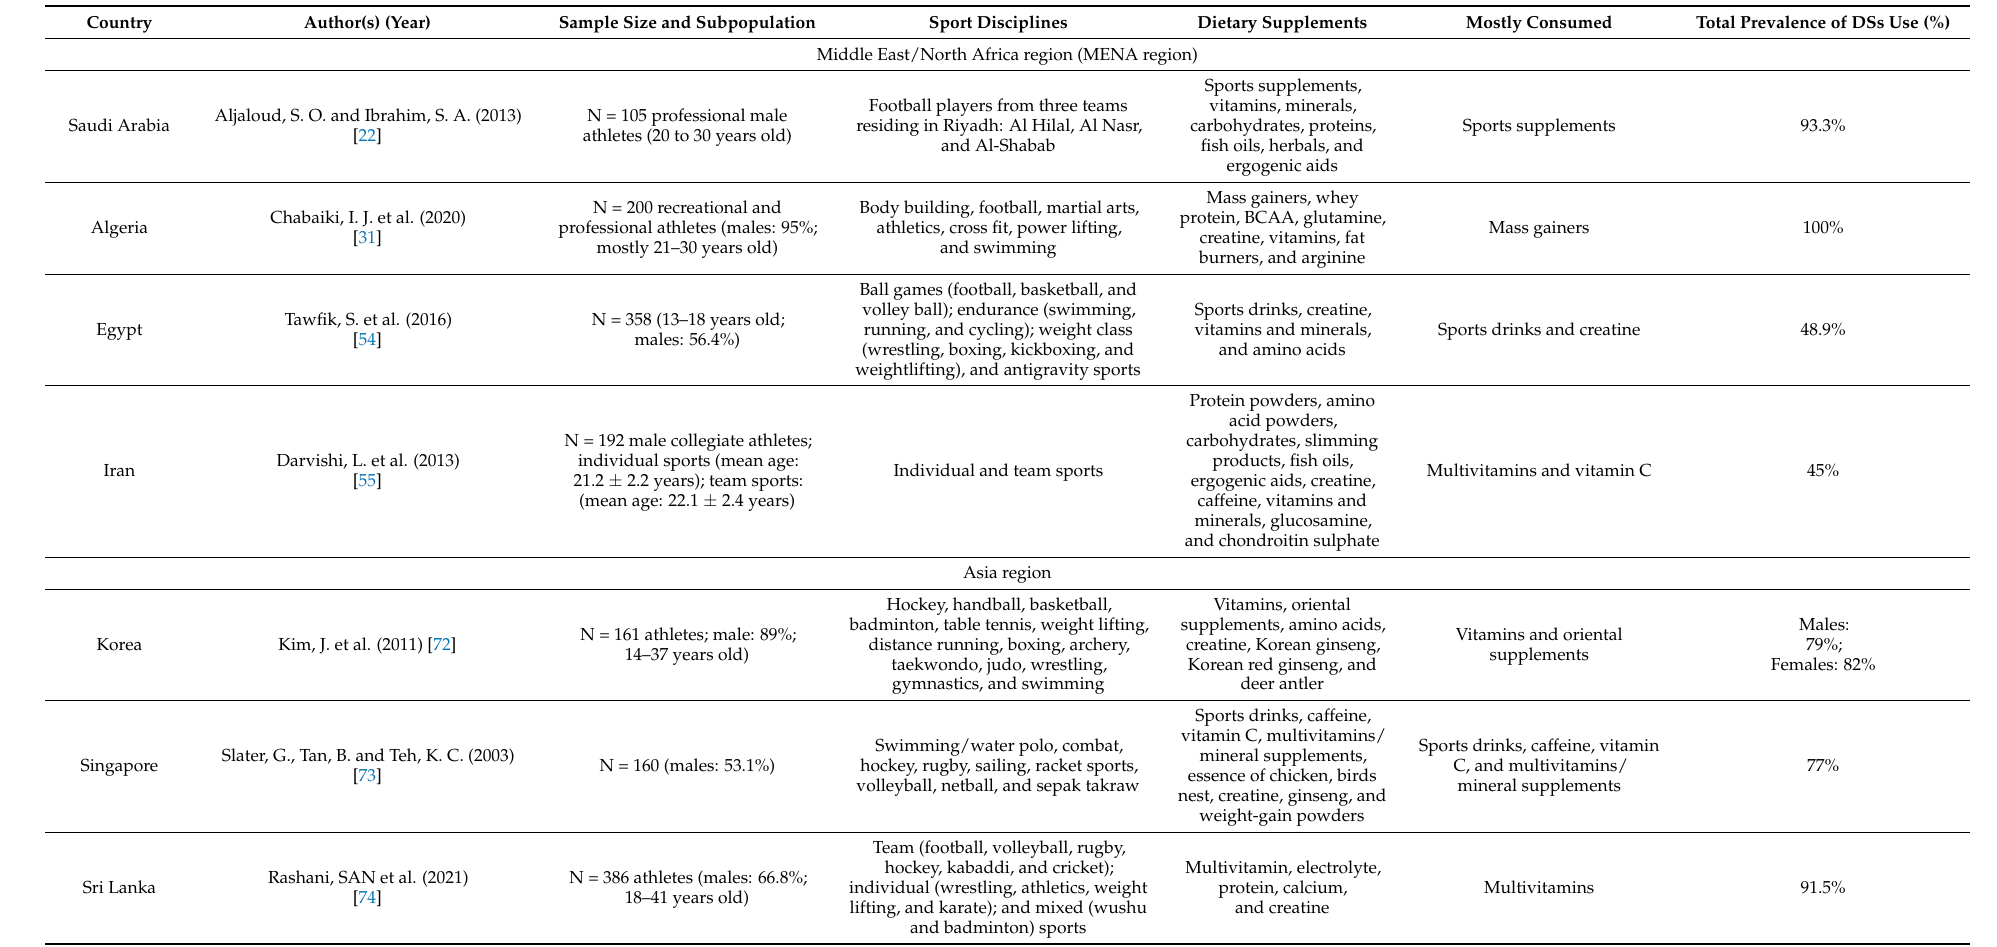
Table 5. An overview of the dietary supplementation patterns of athletes in different